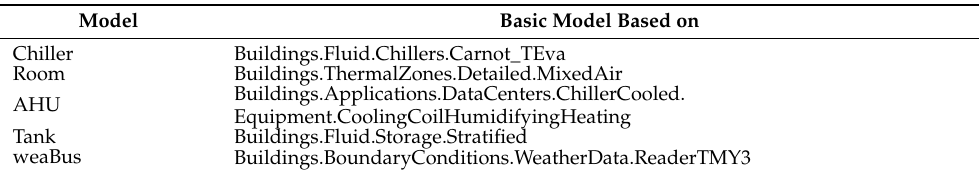
Table 5. Main component selection in